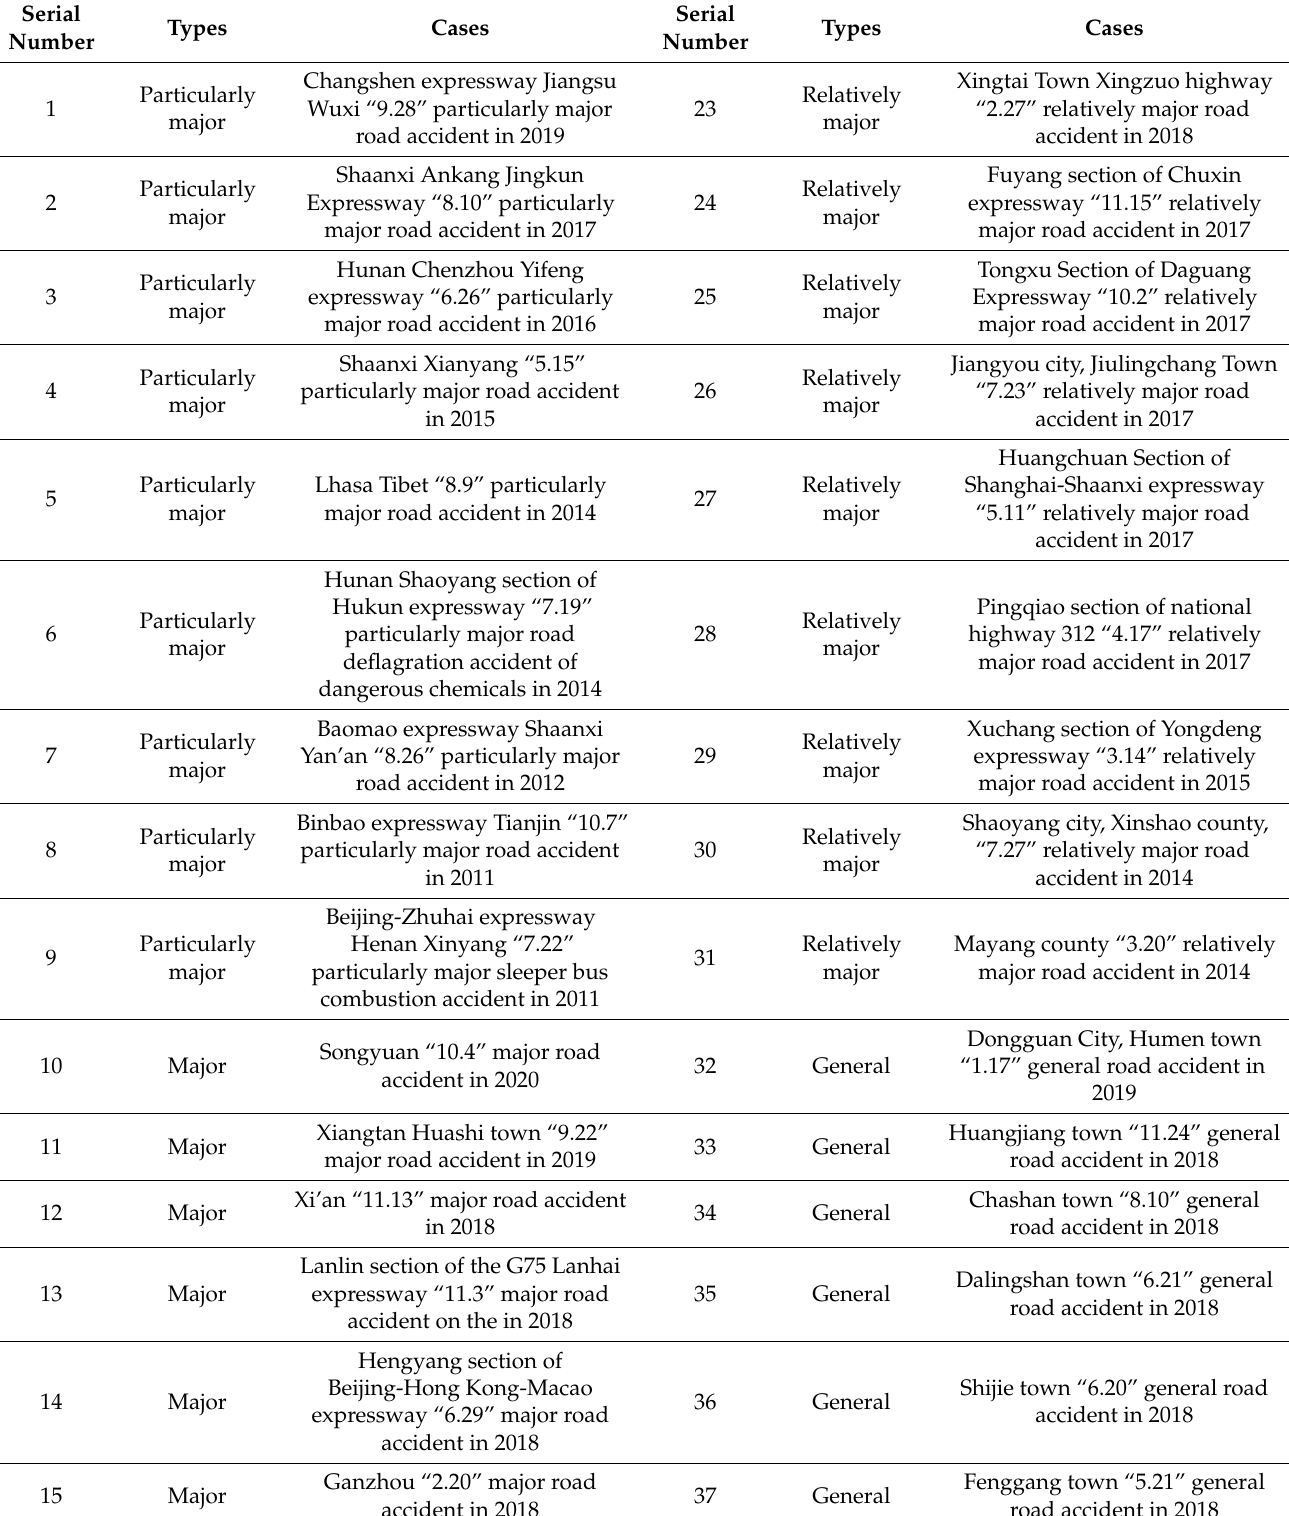
Table A1. List of selected case database of road accidents that occurred in China between 2011 and